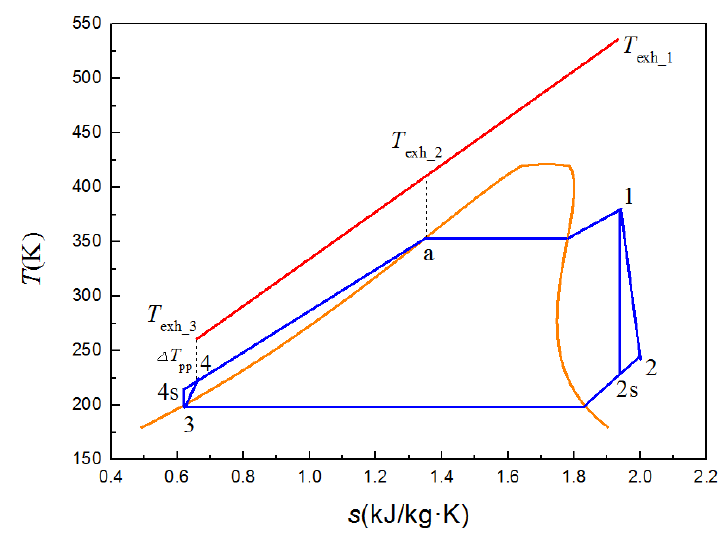
Figure 9. T-s diagram of the ORC system.